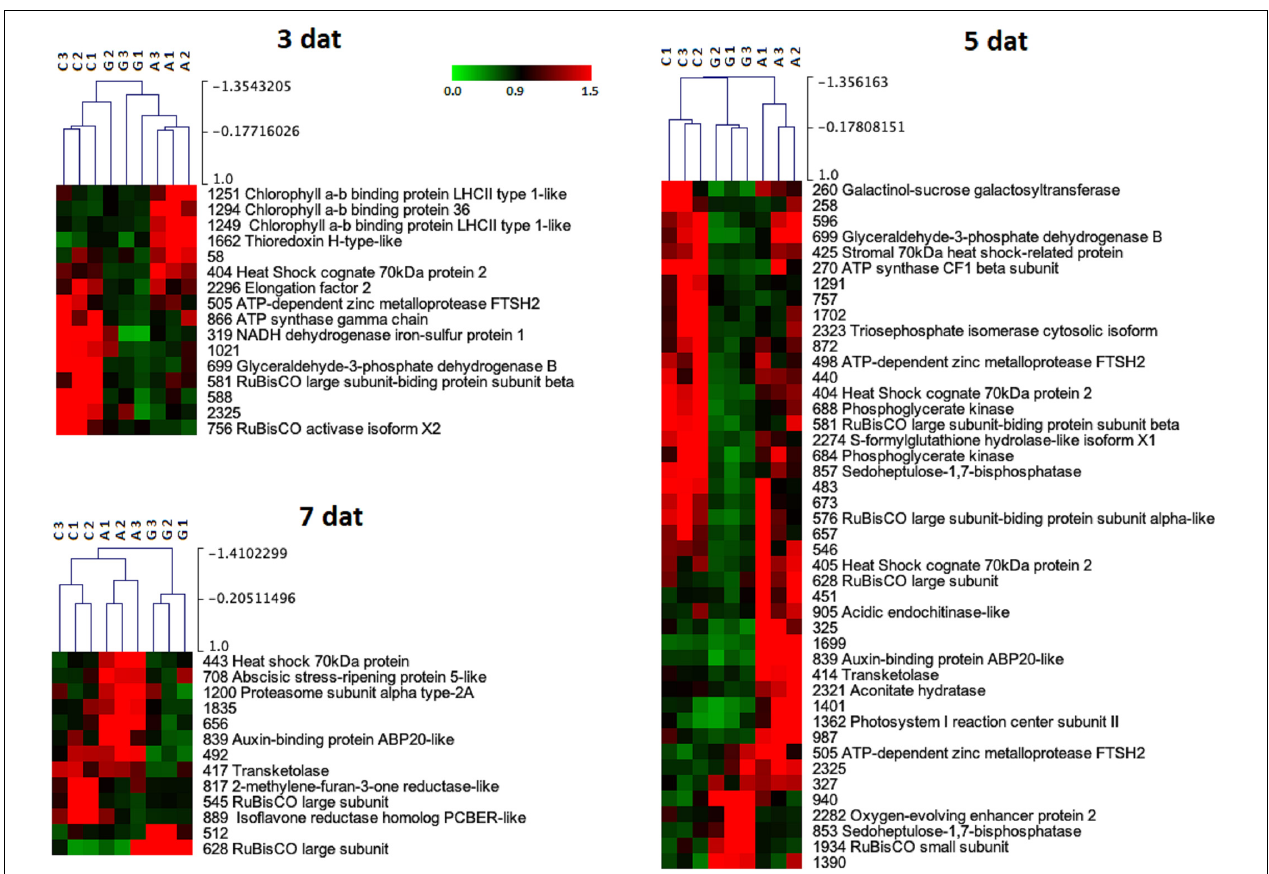
FIGURE 5 | Hierarchical cluster analysis of the proteins that significantly changed in abundance ( p -value < 0.05) between Greenforce CuCa (G), ASM (A), and Control (C) at 3, 5, and 7 days after treatments. The signals are shown in a red-green color scale, from a gradient of red (higher expression) to green (lower